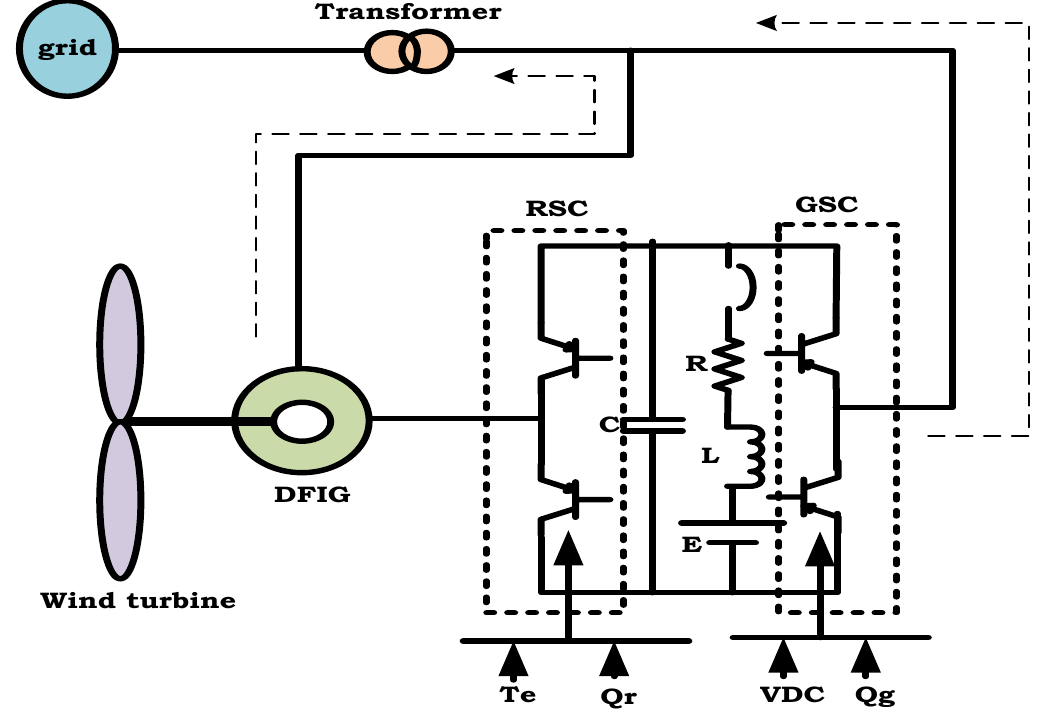
Figure 1. Block diagram representation of proposed wind energy